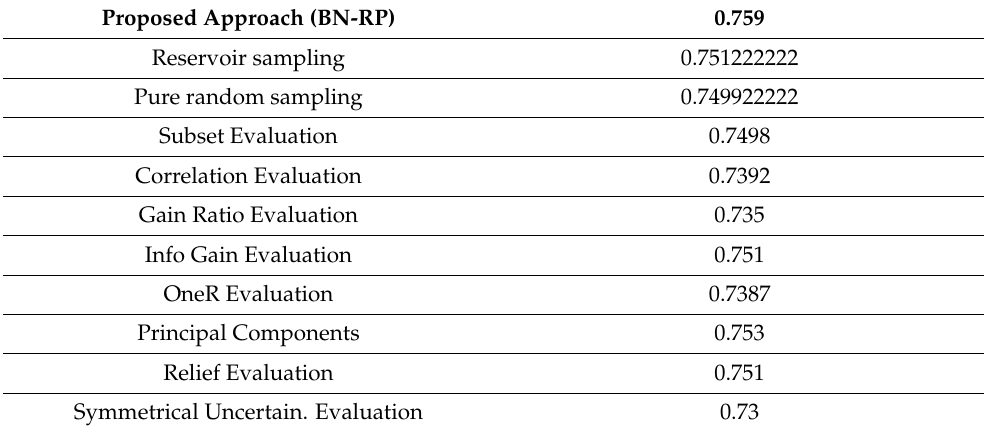
Table 6. Comparison of the proposed approach with feature/data selection approaches.